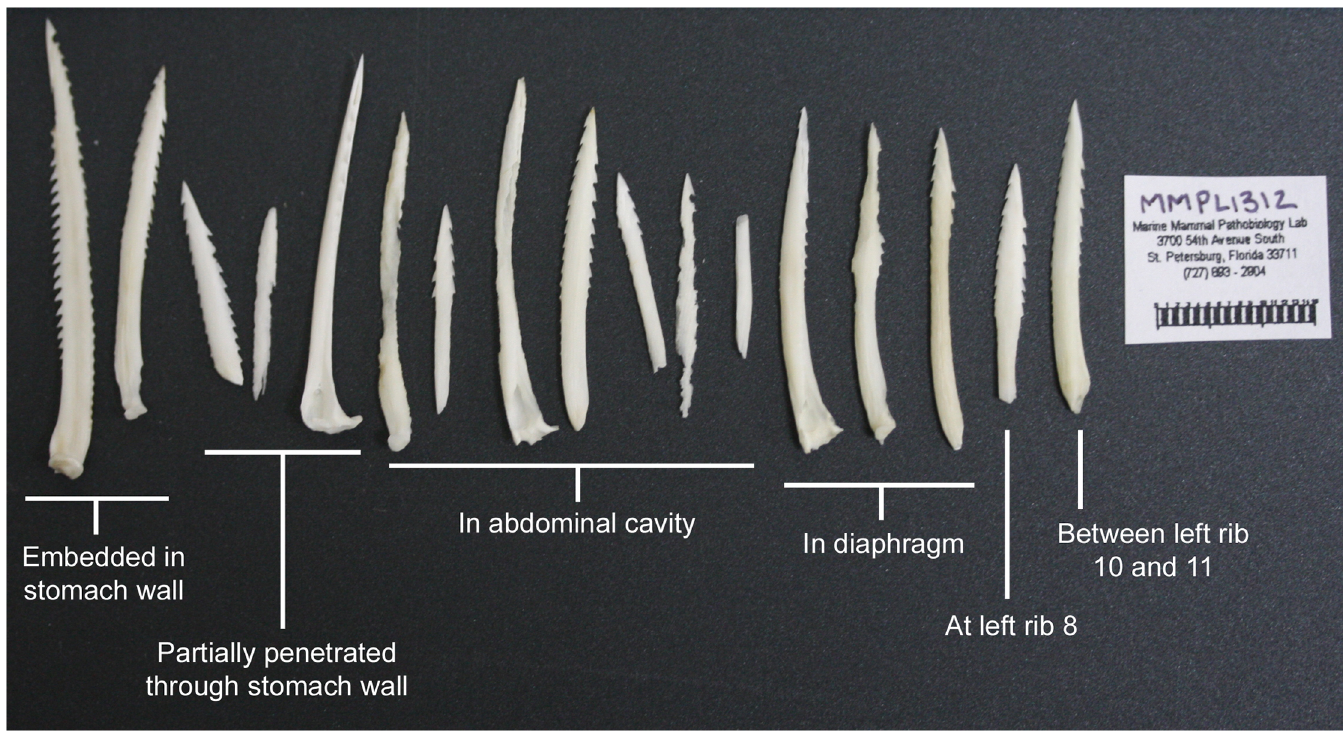
Fig 5. Injurious catfish spines found during the necropsy of a single bottlenose dolphin (176 cm male, SEUS ID No. SER13-1180,